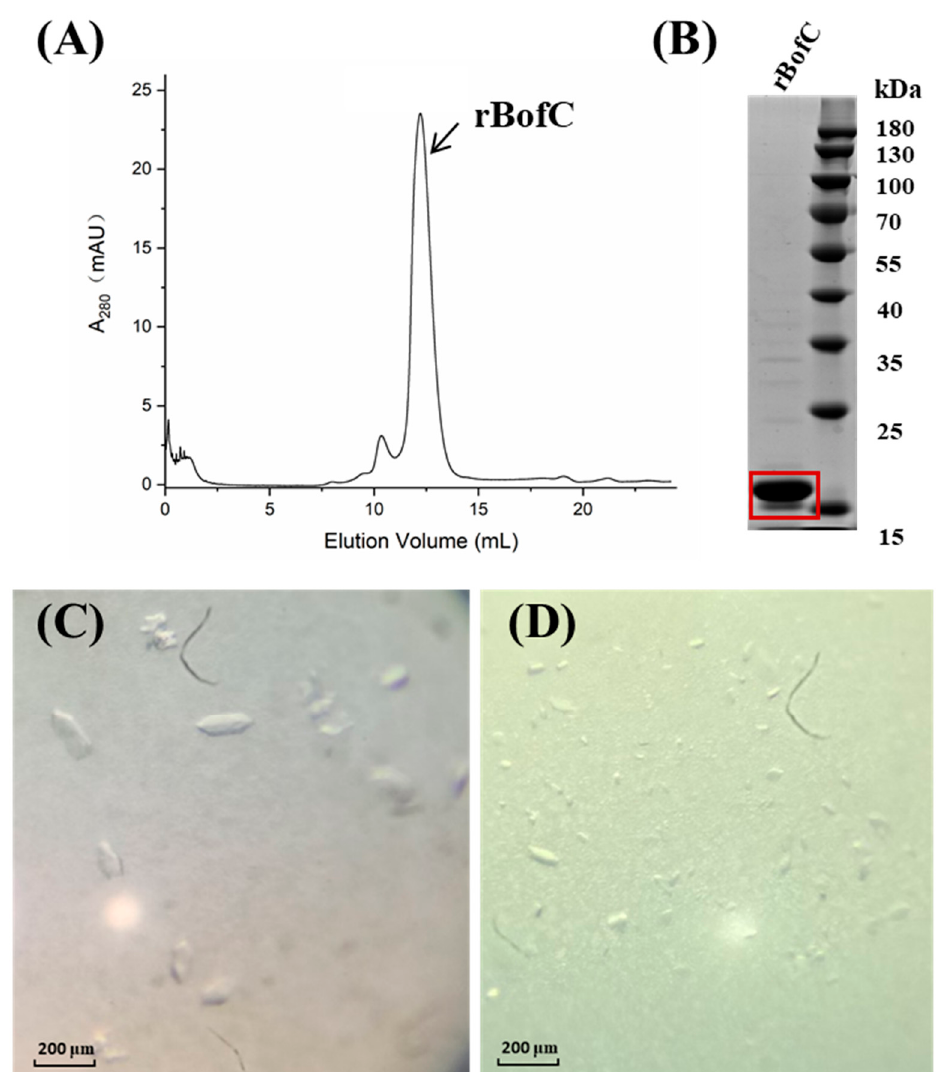
Figure 1. Purification and crystallization of rBofC. ( A ) Size-exclusion chromatography (superdex75 10/300 GL) profile of rBofC protein where 200 μ L rBofC (0.5 mg/mL) was injected in the superdex75 10/300 GL column, and the elution volume of rBofC was 12.2 mL. ( B ) 15% SDS-PAGE analysis of the purified rBofC by superdex75 10/300 GL. B: fractions of peak BofC; L: Ladder. ( C ) Crystals of rBofC in 0.1 M sodium acetate trihydrate pH4.5 and 30% w/v polyethylene glycol 1500. ( D ) Crystals of rBofC in 0.1 M sodium acetate trihydrate pH4.5 and 30% w/v polyethylene glycol monomethyl ether 5000. Scale bars are 200 μ m.